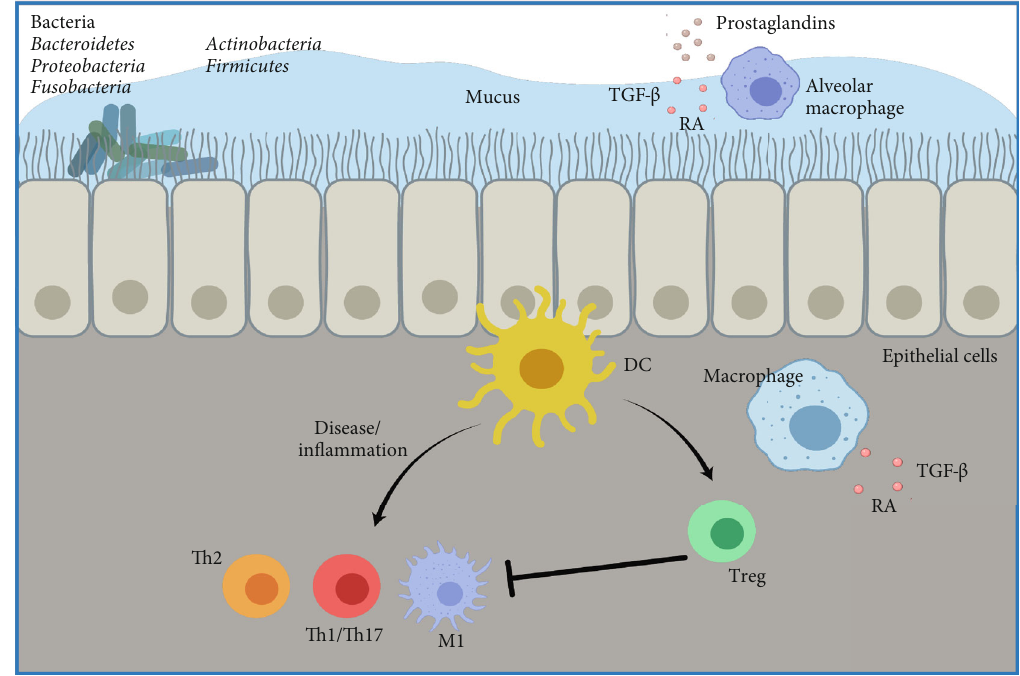
Figure 3: The immune tolerant microenvironment in the lung. Schematic representation of di ff erent components participating in lungs immune tolerance. Airway epithelial cells act as a primary barrier through mucociliary clearance and secretion of soluble factors. Alveolar macrophages have an immunosuppressive function, secreting prostaglandins and TGF- β and can also contribute to Treg di ff erentiation by secreting retinoic acid and TGF- β . Lung microbiota such as Bacteroidetes, Proteobacteria, and Fusobacteria phyla also contribute to this tolerance by maintaining a healthy lung environment. Lung resident DC and macrophages keep an immunosuppressive milieu in healthy lung conditions; however, due to changes in lung environment, which may include variations in microbiota, in fl ammation status, or chronic lung diseases, an in fl ammatory state can be instead